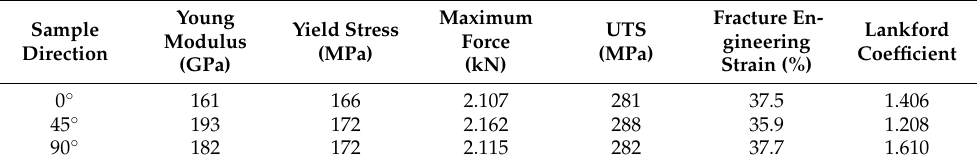
Figure 3. Experimental and numerical engineering stress–strain curves for tensile specimens of the EK4 steel oriented at 0°, 45° and 90° with respect to the rolling direction. Table 1. Average mechanical parameters obtained from the tensile tests of the EK4 deep drawing steel.